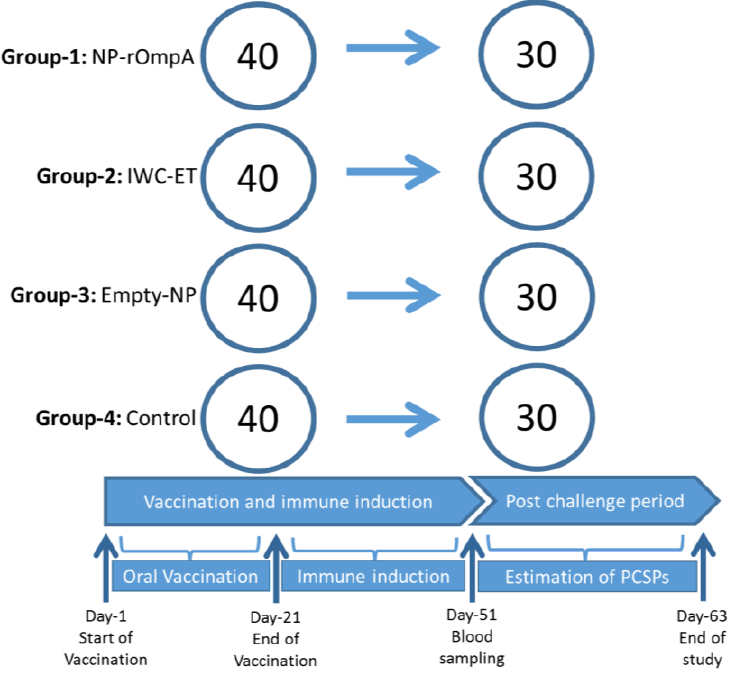
Figure 1. The study design for the oral vaccination trial of carp against E. tarda using different vaccines. Four vaccine groups were each allocated 40 fish. Group 1 was allocated the chitosan NP rOmpA vaccine, designated NP-rOmpA. Group 2 was vaccinated with an inactivated whole cell (IWC) E. tarda vaccine designated, IWC-ET. Group 3 was vaccinated with empty nanoparticles, without the rOmpA antigen, designated NP-Empty; Group 4 was left unvaccinated and served as the control group. The study timeline for the vaccination trial was segmented into (i) the oral vaccination period of 21 days; (ii) an immune induction period of 51 days post vaccination (dpv), and (iii) the post-challenge period. Blood samples were collected from 10 fish in each group and challenged at 51 dpv. The vaccination trial ended at 63 dpv when fish stopped dying after challenge.